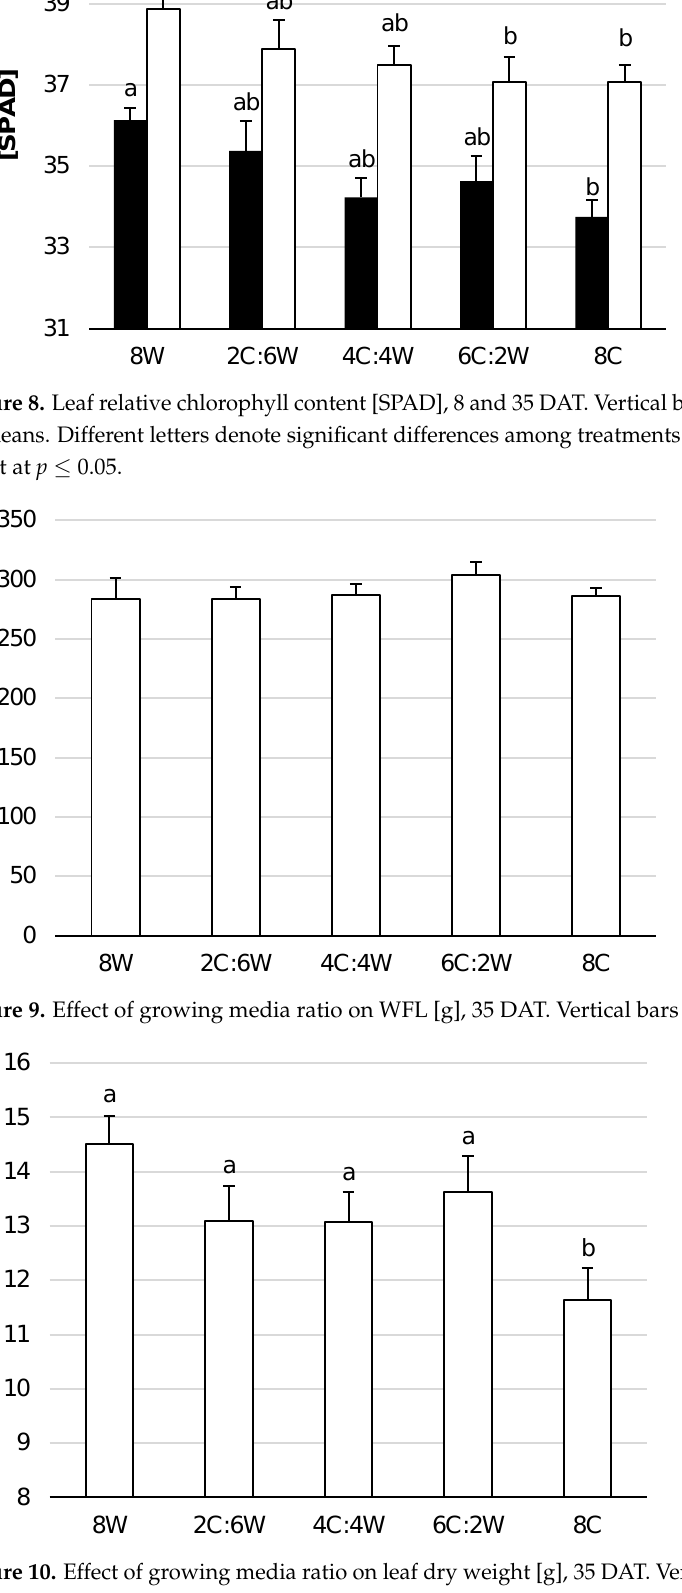
Figure 10. Effect of growing media ratio on leaf dry weight [g], 35 DAT. Vertical bars denote standard error. Different letters denote significant difference according to the Student’s t -test at p ≤ 0.05. Leaf area was significantly increased in the 8W substrate ratio (299.21 ± 13.63 cm 2 ) compared to 8C, 4C:4W, 2C:6W and 6C:2W (268.15 ± 6.90, 267.94 ± 10.10, 263.69 ± 7.65 and 262.55 ± 5.10 cm 2 , respectively) substrate treatments, 35 DAT (Figure 11). Accordingly, the results of leaf texture hardness (leaf firmness) indicate a range of leaf puncture values of 1150 to 1350 g force, with substrate 8W causing a significant increase in leaf hardness by 12.8 % compared to the 8C substrate, 35 DAT. In more detail, leaf texture hardness demon- strated a significantly reduction in the substrate ratio of 8C (1188 ± 93.38 g) compared to the substrate treatments of 8W (1339.83 ± 74.99 g), without any statistical difference being observed between 2C:6W, 4C:4W and 6C:2W (1315.33 ± 92.58, 1228.66 ± 86.41 and 1280.83 ± 103.24 g, respectively), 35 DAT (Figure 12).